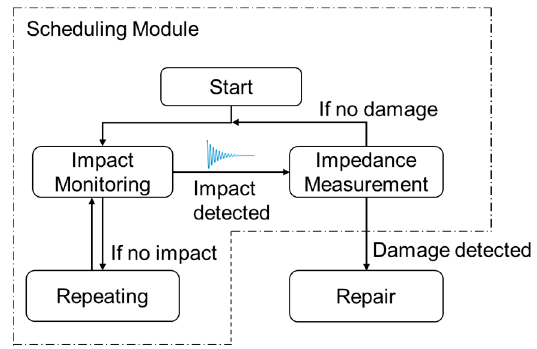
Figure 8. An application example of a scheduling module (on software).